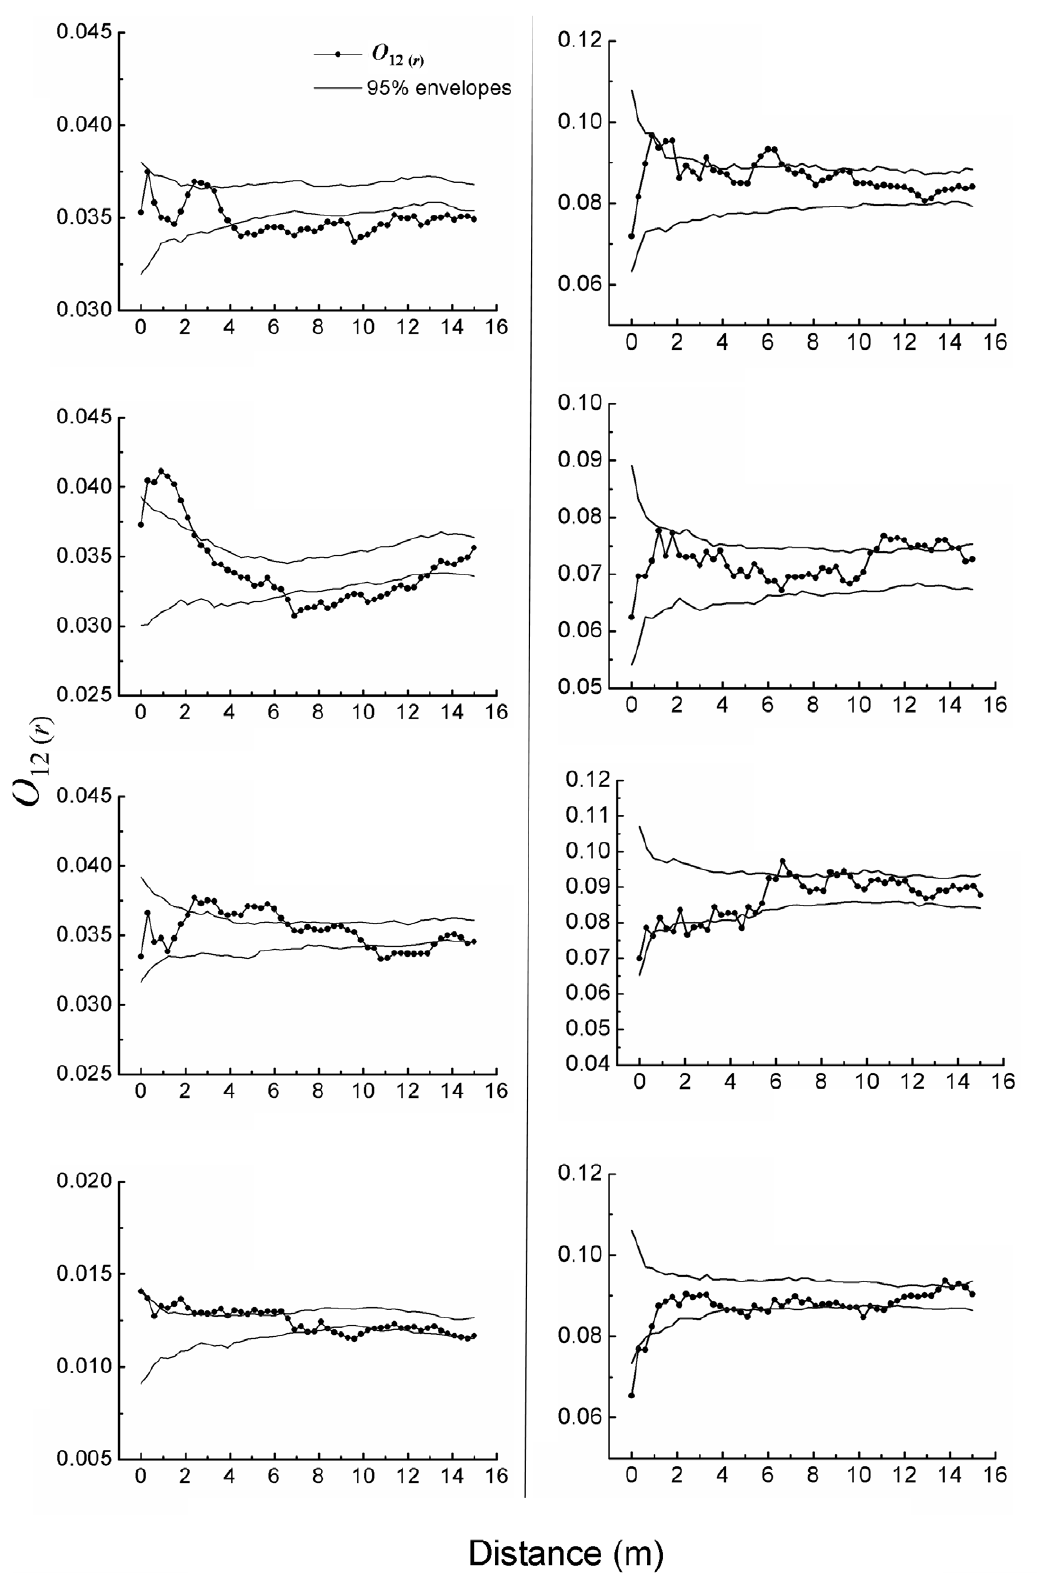
Figure 4. Spatial association of A.ordosica saplings with adults at the patch edges (left column, a) and the patch centers (right column, b), one sub-figure per plot.